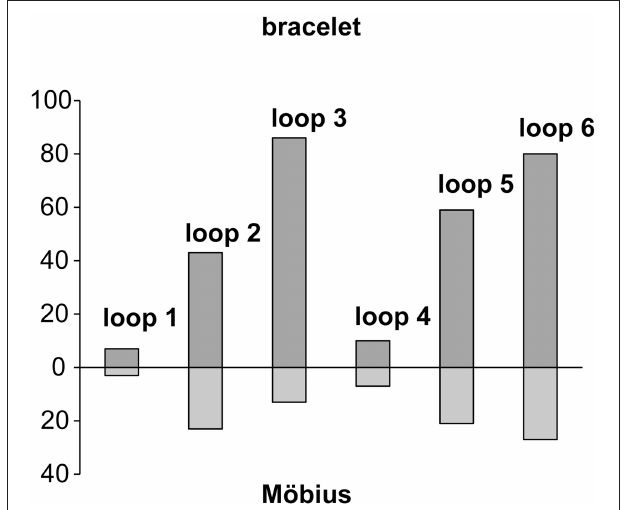
FIGURE 7 | Intercysteine loops of Möbius and bracelet cyclotides illustrating the plasticity of the cyclotide scaffold. The total number of different loops between each of the cysteines is shown as bars in upwards direction for the bracelet (including the hybrids) and downwards for Möbius cyclotide (including linear variants). The loops with longer sequences (2, 3, 5, and 6) clearly have more variants than the loops with few amino acids (1 and